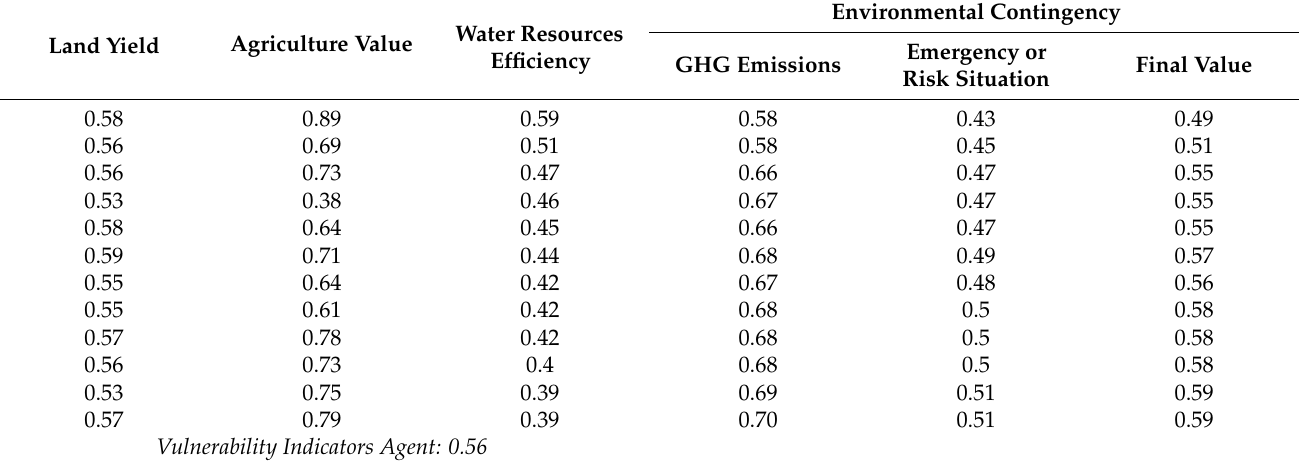
Table 9. Vulnerability results (Vulnerability Indicators